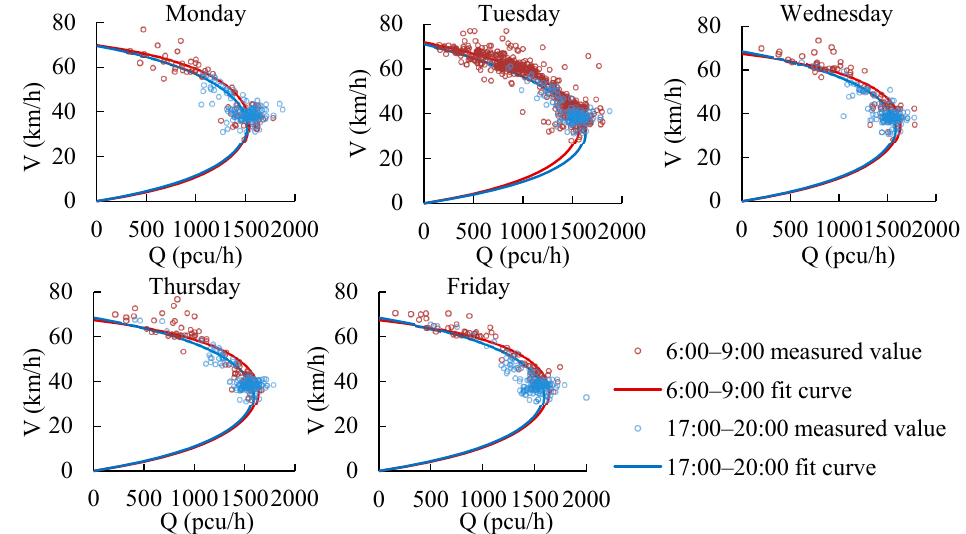
Figure 10. Average speed-flow models of peak hours on different weekdays on expressways.